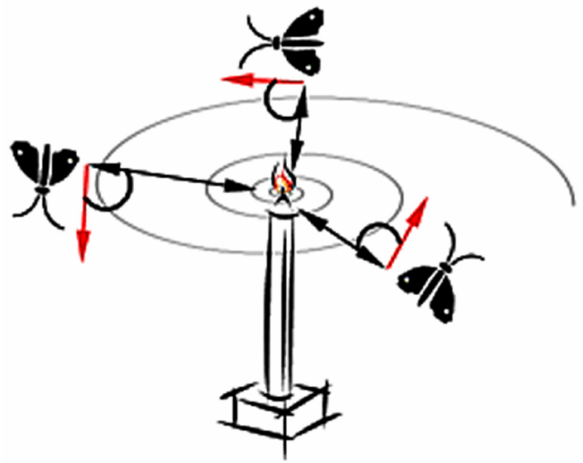
Figure 8. Spirally flying path around near light sources [34]. (Reproduced with permission by